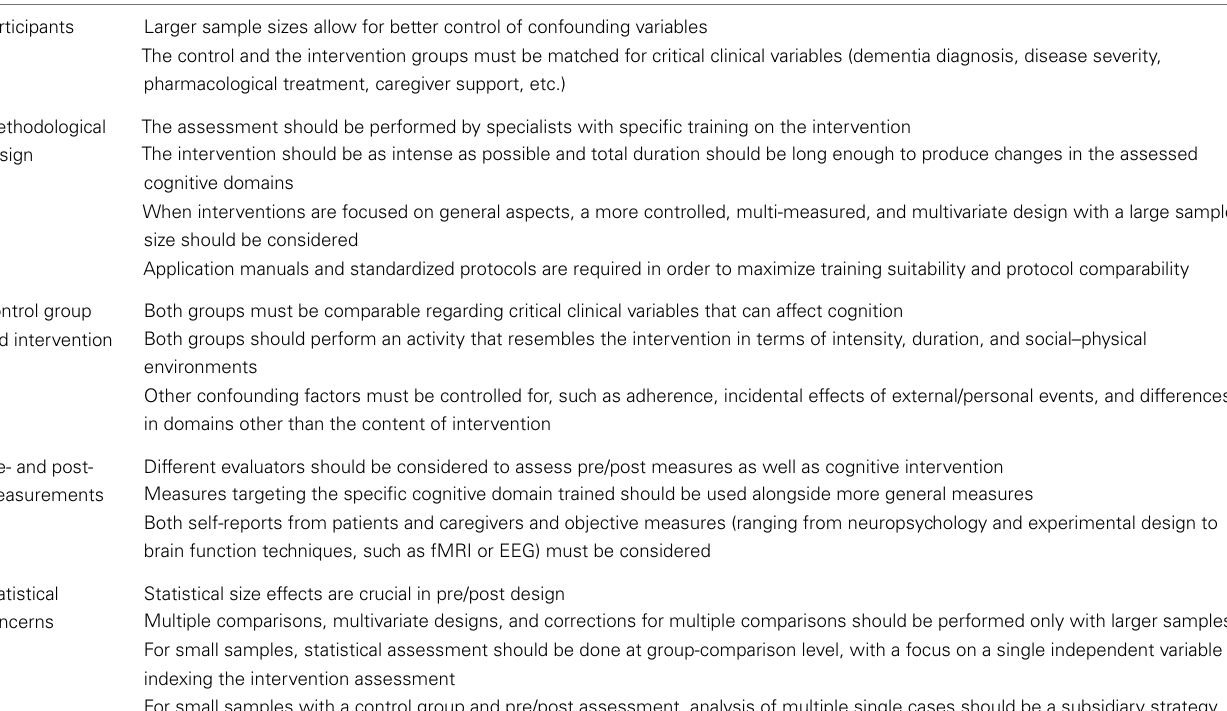
Table 1 | Relevant factors for improving research quality of cognitive interventions